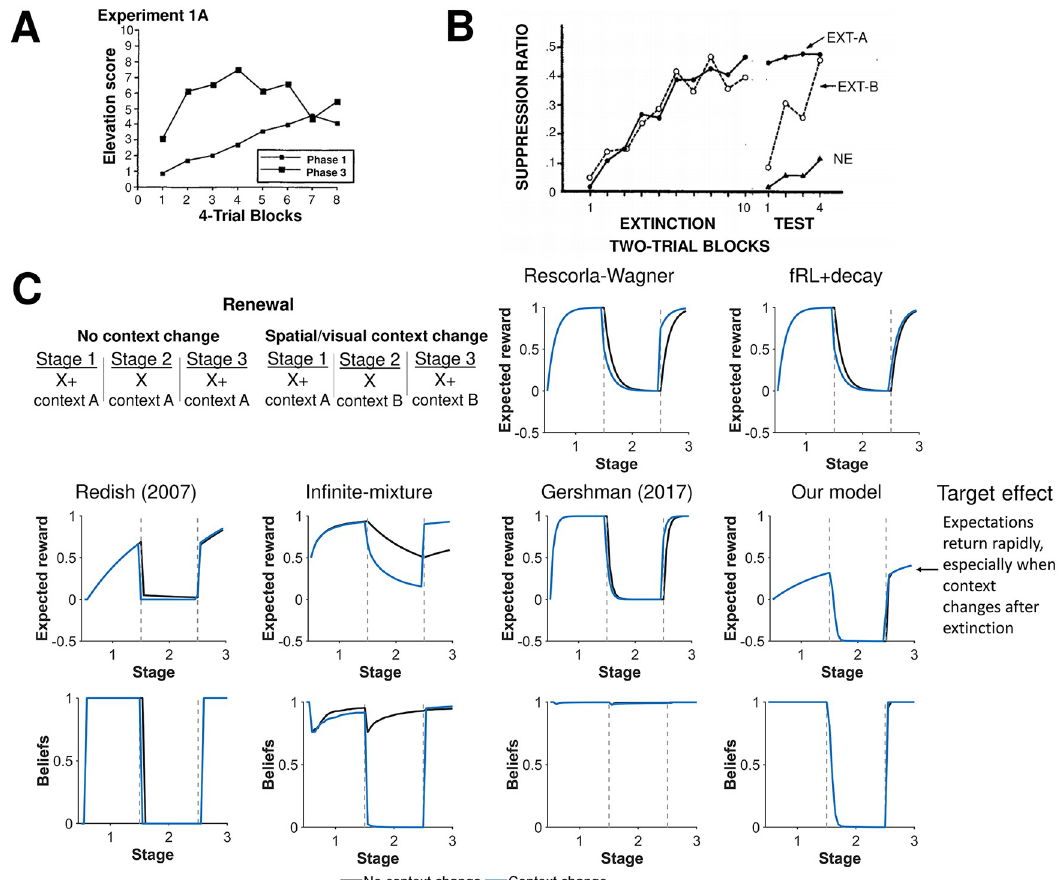
Fig 7. Changes in context influences beliefs. A) Experimental results from Ricker and Bouton [46] demonstrating a faster response during reacquistion (phase 3) than acquisition (phase 1) after extinction (phase 2). Reprinted by permission from Springer Nature Customer Service Centre GmbH: Springer Nature, Animal learning and behavior, Reacquisition following extinction in appetitive conditioning, Sean T. Ricker & Mark E. Bouton, (1996). B) Experimental results from Bouton and King [47] demonstrating a more robust return of a fear when extinction occurs in different context (EXT-B) as opposed to the same context (EXT-A) as acquisition. Reprinted from “Contextual Control of the Extinction of Conditioned Fear: Tests for the Associative Value of the Context” by M.E. Bouton and D.A. King, 1983, Journal of Experimental Psychology: Animal Behavior Processes , 9 , p. 252. Reprinted with permission from the American Psychological Association. C) Simulation results of expected rewards when a response is reinstated after extinction with and without a change in a visual/spatial context. The second experiment examines associative strength of cue when a response is reinstated after extinction with and without a change in a temporal context (i.e. a time delay between trials). Our model shows a rapid reinstatement of expectations as the agent switch their beliefs back to the first latent state. Our model also shows that rapid reinstatement is more robust with changes in context, particular in the first few trials of reinstatement. Expected rewards are depicted rather than associative strengths to account for the influence of context on expectations in addition to the cue, since models other than our model treat context as an additional cue. Beliefs are shown for the first latent state. Gray dashed lines demarcate experimental